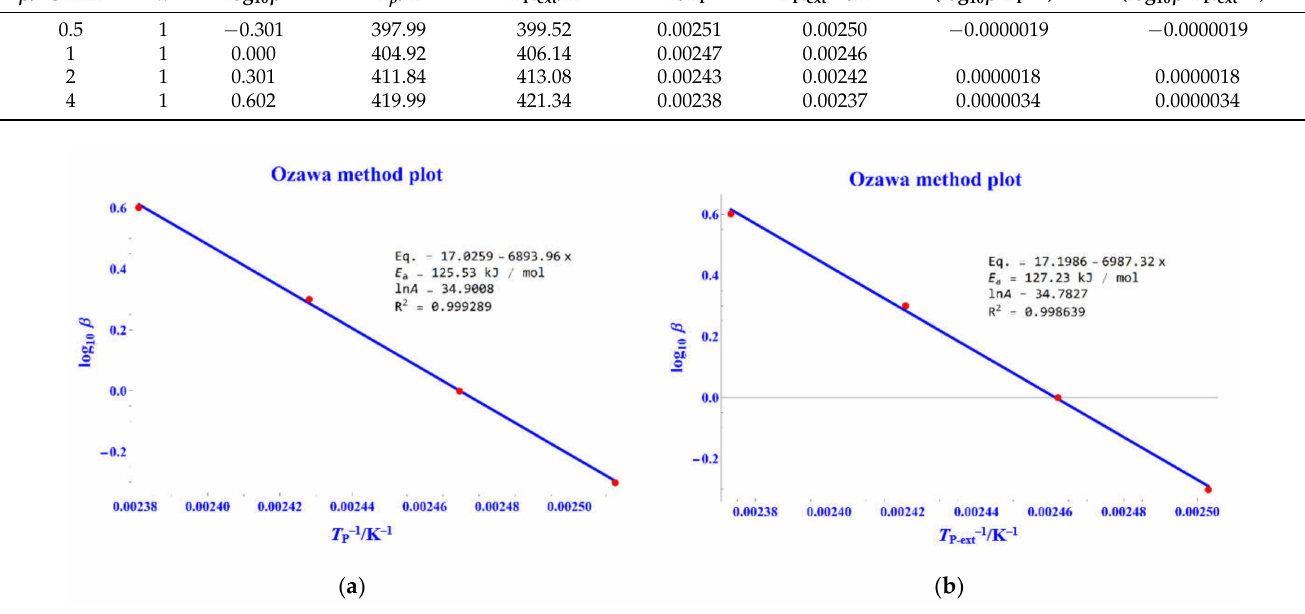
Figure 12. ASTM E698 method plot ( a ) log β versus 1/ T p plot; ( b ) log β versus 1/ T P-ext plot.